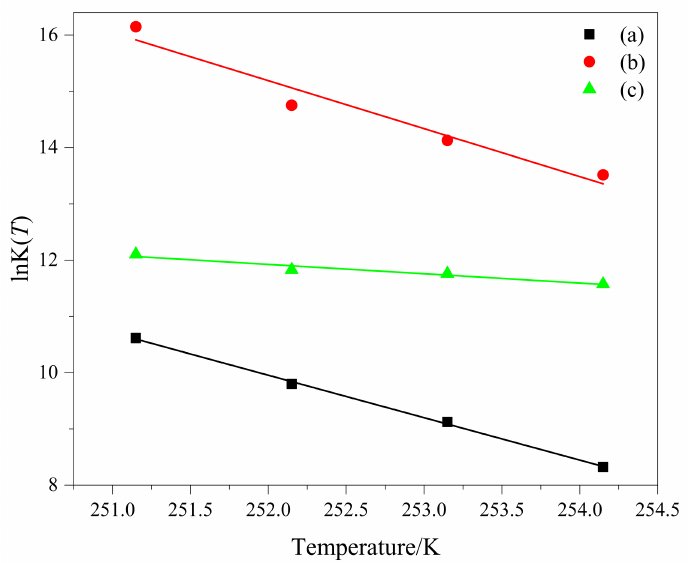
Figure 4. lnK( T ) as a function of temperature T of ( a ) PEG in method 1, ( b ) PEG-PLLA in method 1 and ( c ) PEG-PLLA in method